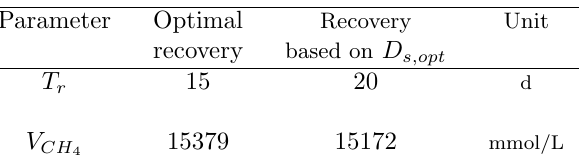
Table 6: Comparison regarding the recovery time and the volume of the produced methane over 100 days between two methane recovery proce- dures with respect to the AR threshold =